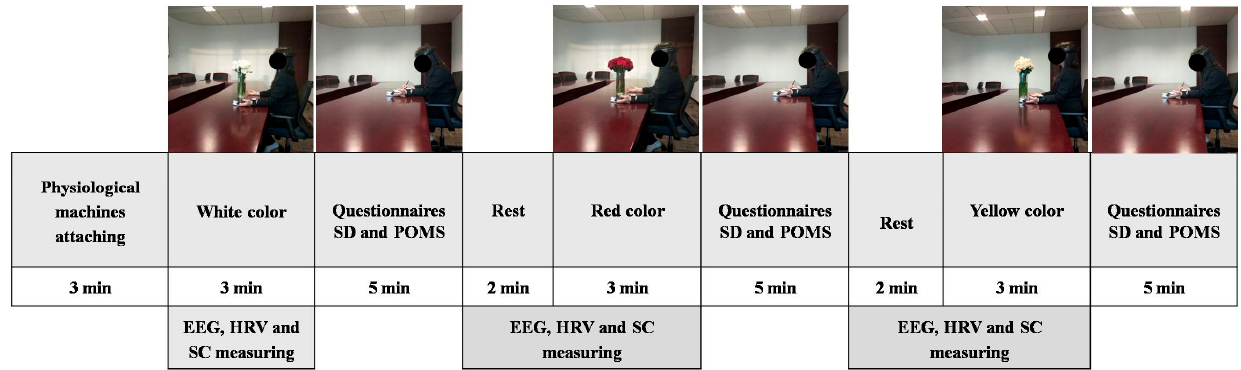
Figure 3. Experimental protocol.